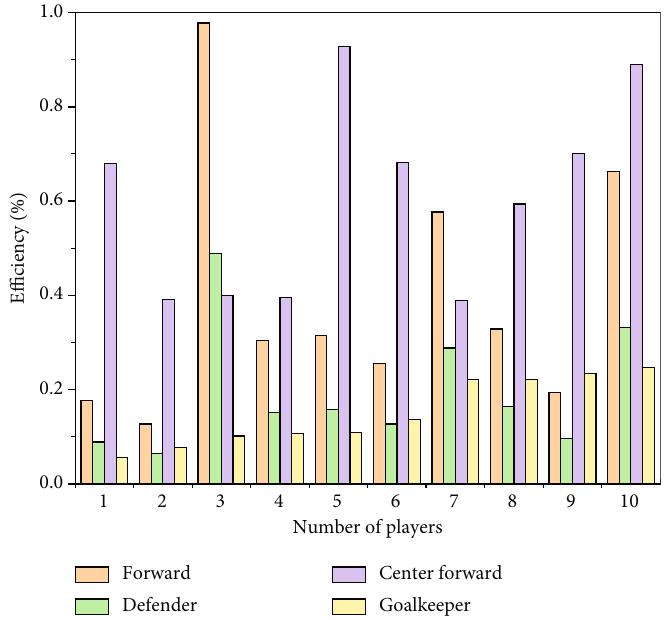
Figure 6: Statistical chart of player e ffi ciency index.